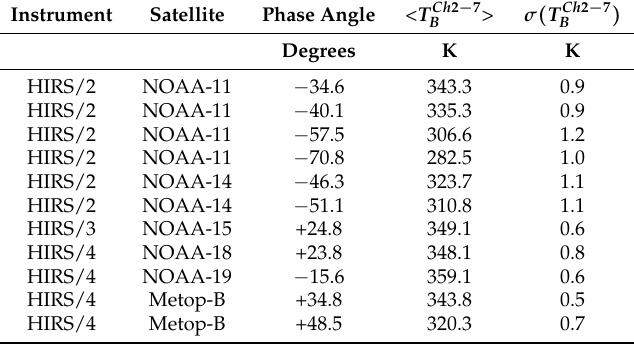
Figure 4. Position of the Moon in the along-track direction according to each infrared channel of HIRS/4 on NOAA-19 during its intrusion in the DSV on 2012-03-04 at 5:07 UTC. The values are relative to the position of the Moon in channel 19, and they are positive, if the pointing direction of a channel is displaced in the flight direction. The relationship between the central wavelength of the channels and the displacement is plotted as two different red lines for the SW and the LW channels. The channel numbers are, from left to right: 19, 18, 17, 16, 15, 14, 13, 12, 11, 9, 8, 10, 7, 6, 5, 4, 3, 2. Table 5. Average brightness temperatures and their standard deviations for channels 2–7 at different phase angles of the Moon. The central wavelengths of these long-wave CO 2 channels lie between 13.3 and 14.8 µ m for HIRS/2, 3, and 4; their calibration has been studied in detail by